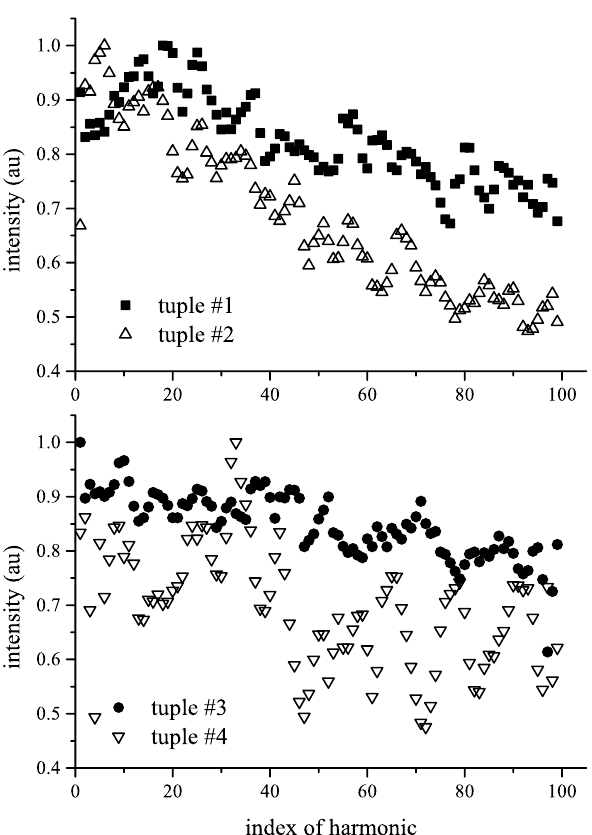
Fig. 7. The values of intensities of Fourier harmonics for selected parameters: tuple#1: f 5.01187,1,0.1,10,0.01,1,0.01 g , tuple#2: f 10,1,10,10,0.01,1,0.01 g , tuple#3: f 0.0794328,1,0.1,10,0.01, 1,0.01 g , tuple#4: f 10,0.01,0.01,0.1,0.75,0.95,0.25 g